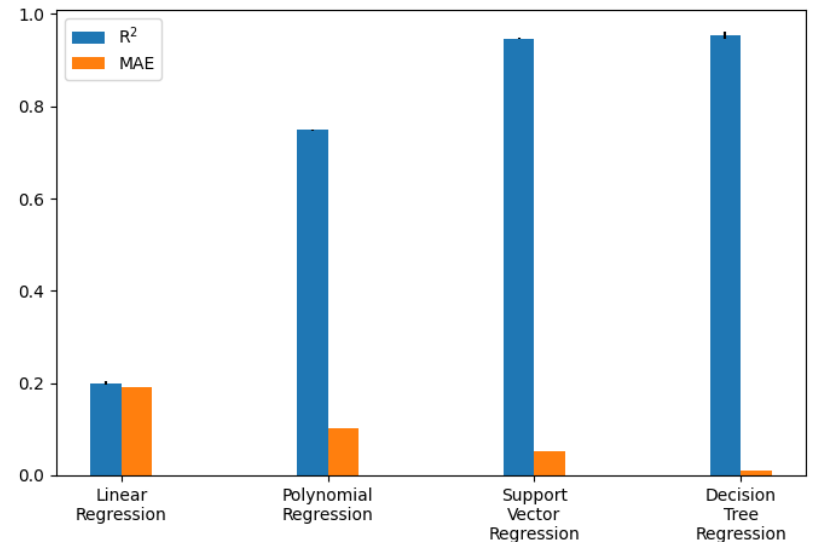
Figure 9. Regression model performance as bar chart (exact values are in Table 5).